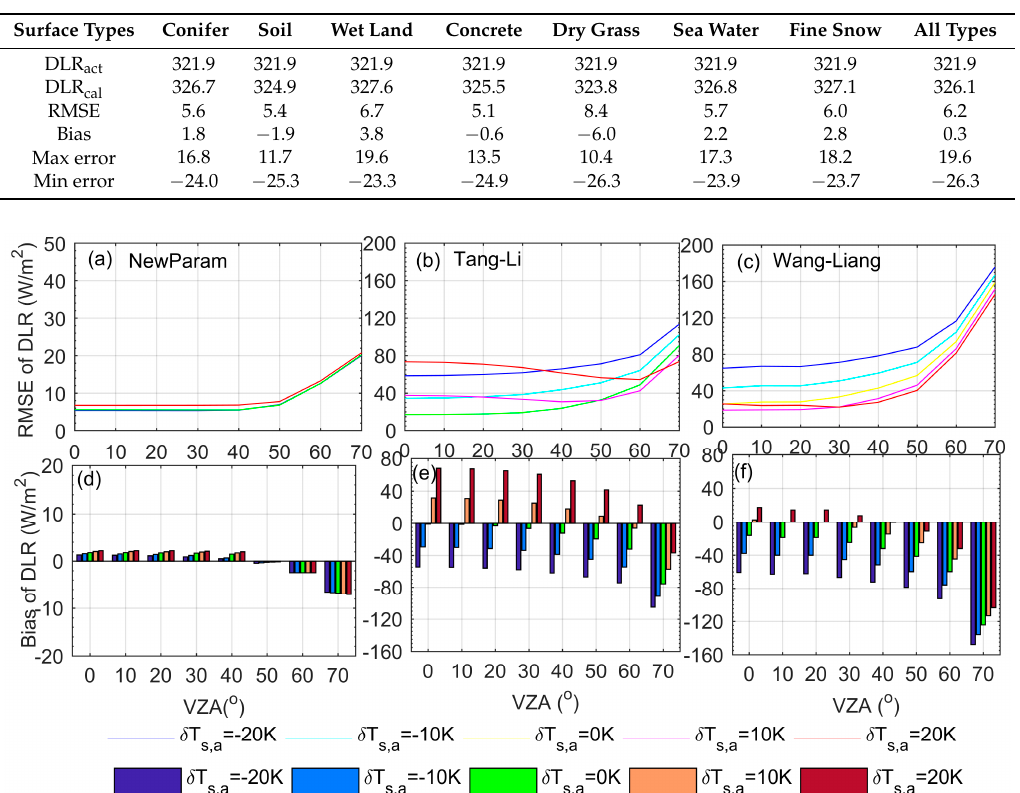
Table 3. The mean value of actual and calculated DLRs (DLR act and DLR cal ), root mean square error (RMSE), bias, maximum error and minimum error between actual DLRs, and those calculated from